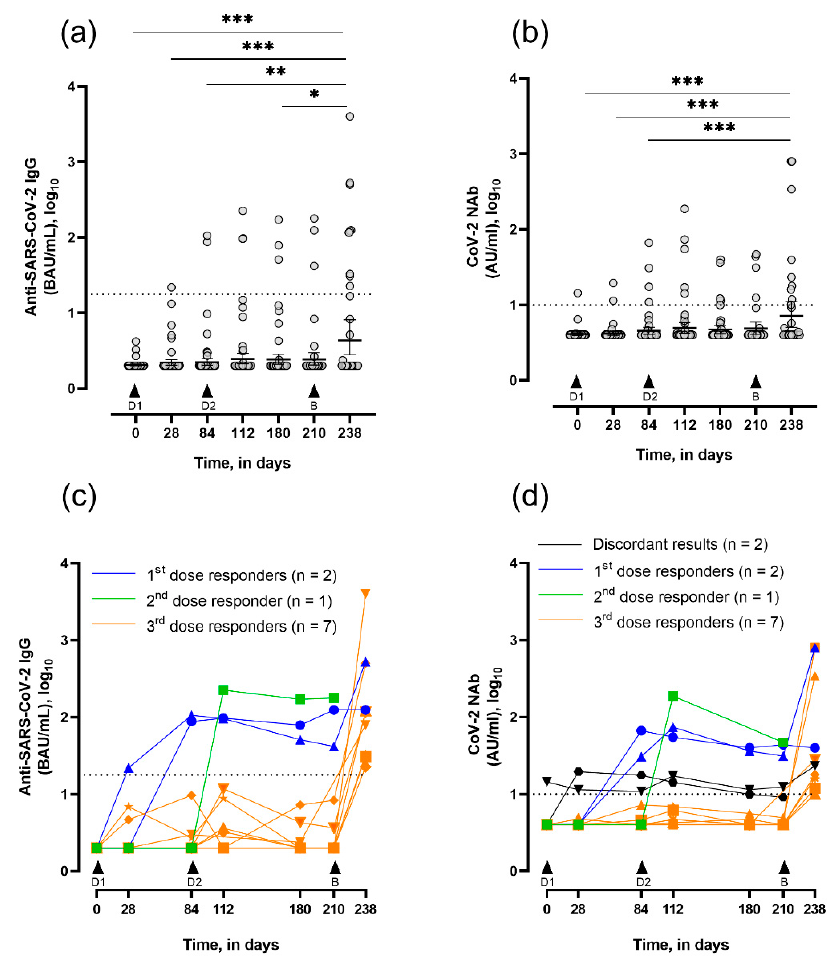
Figure 2. Evolution of serum SARS-CoV-2 IgG titers and neutralizing capacity in vaccinated LTRs, assessed at days 0 (n = 49), 28 (n = 47), 84 (n = 49), 112 (n = 44), 180 (n = 42), 210 (n = 32) and 238 (n = 28). Data are expressed in log 10 . ( a ) Quantitative titers of anti-SARS-CoV-2 IgG at consecutive timepoints (geometric mean in BAU/mL ± 95% CI). * p <0.05, ** p <0.01, and *** p <0.001 by the Krus- kal–Wallis test followed by a post–hoc Dunn’s tests. ( b ) Quantitative titers of neutralizing antibodies (NAbs) at consecutive time-points (geometric mean in AU/mL ± 95% CI). *** p <0.001 by the Krus- kal–Wallis test followed by a post hoc Dunn’s tests. ( c ) Evolution of anti-SARS-CoV-2 IgG titers in seropositive LTRs with first dose responders represented in blue (n = 2), second dose responder in green (n = 1), and booster dose responders in orange (n = 7). ( d ) Evolution of NAbs titers in sero- positive LTRs with first dose responders represented in blue (n = 2), second dose responder in green (n = 1), and booster dose responders in orange (n = 7). Patients with discordant results between IgG and NAbs are represented in black (n = 2). Dotted black lines represent the positivity cut-offs for IgG measurement ( ≥ 17.8 BAU/mL, i.e., 1.25 in log 10 ) and for NAbs measurement ( ≥ 10 AU/mL, i.e., 1 in log 10 ). D1 and D2, respectively, are the first and second dose of ChAdOx1; B is the booster dose, BNT162b2. Table 2. Anti-SARS-CoV-2 IgG and NAbs titers, and proportion of seropositive LTRs at each collec- tion time point. LTR Participants